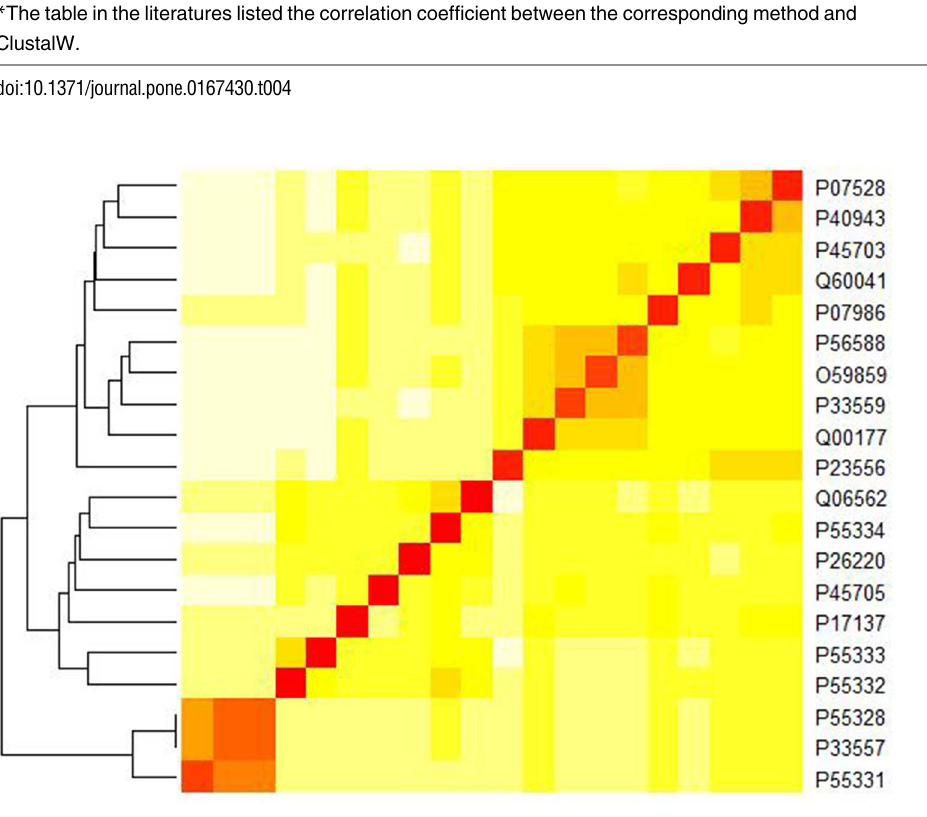
Fig 7. A heat map showing the similarity of 20 xylanasesin the F10 and G11